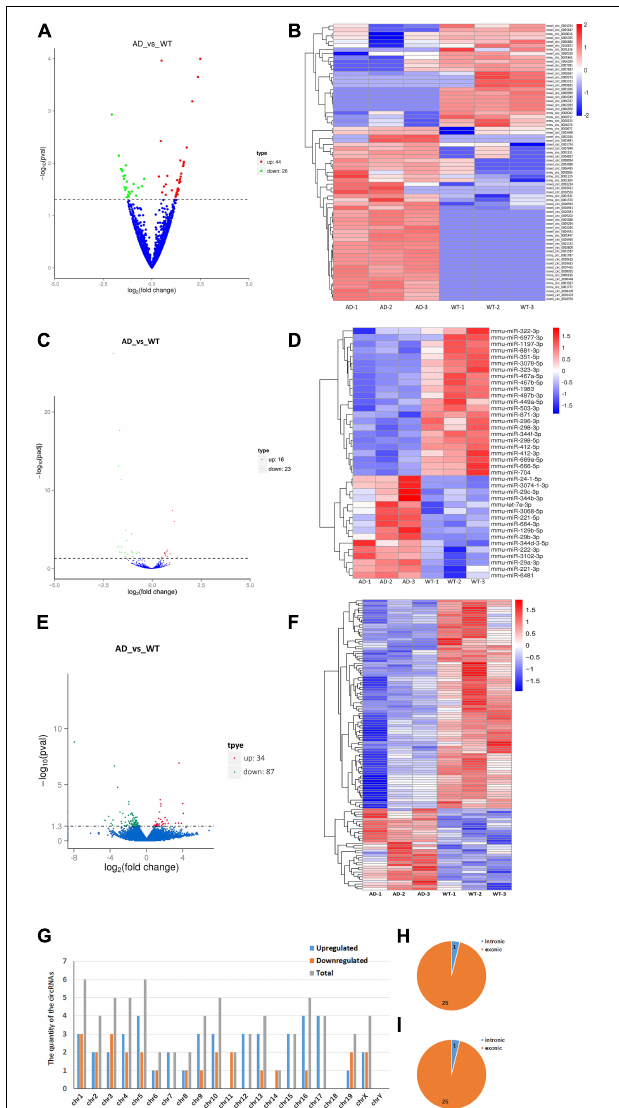
FIGURE 1 | Expression profiles of distinct RNAs. (A,B) Expression profiles of circRNAs. (A) In the volcano plots, green, red, and blue points represent circRNAs that were downregulated, upregulated, and not significantly different in 8-month APP/PS1 mice relative to 8-month WT mice. (B) Cluster analysis of expression of circRNAs. Red and blue: increased and decreased expression, respectively. (C,D) Expression profiles of miRNAs. (C) In the volcano plots, green, red, and blue points represent miRNAs that were downregulated, upregulated, and not significantly different in 8-month APP/PS1 mice relative to 8-month WT mice. (D) Cluster analysis of expression of miRNAs. Red and blue: increased and decreased expression, respectively. (E,F) Expression profiles of mRNAs. (E) In the volcano plots, green, red, and blue points represent mRNAs that were downregulated, upregulated, and not significantly different in 8-month APP/PS1 mice relative to 8-month WT mice. (F) Cluster analysis of expression of mRNAs. Red and blue: increased and decreased expression, respectively. (G–I) Chromosomal distribution of differentially expressed circRNAs in hippocampal of APP/PS1 mice. (G) Chromosomal localization of differentially expressed circRNAs in hippocampal of APP/PS1 mice. (H) Gene localization of upregulated circRNAs in hippocampal of APP/PS1 mice. (I) Gene localization of downregulated circRNAs in hippocampal of APP/PS1 mice.